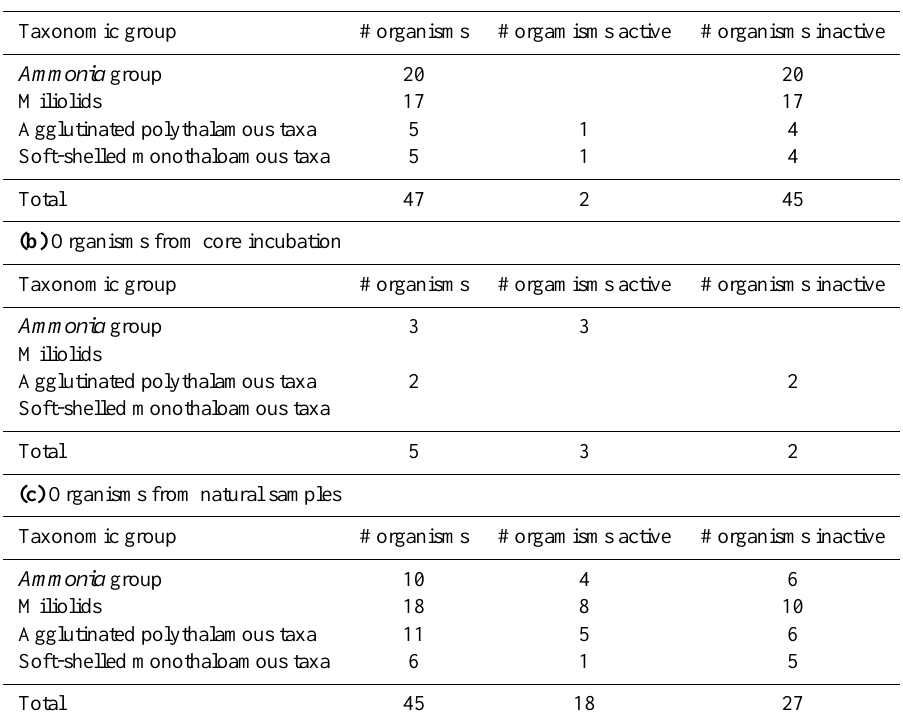
Table 1. Results of optical microscopy (OM) observations performed on different taxonomic groups from different samples. Ac- tive=individuals that displayed pseudopodial activity; inactive=individuals that did not show pseudopods. Inactive individuals may be alive but in a quiescent state (based on cytoplasmatic color, presence of sediment in front of the aperture and presence of pigments inside the cell). See text for